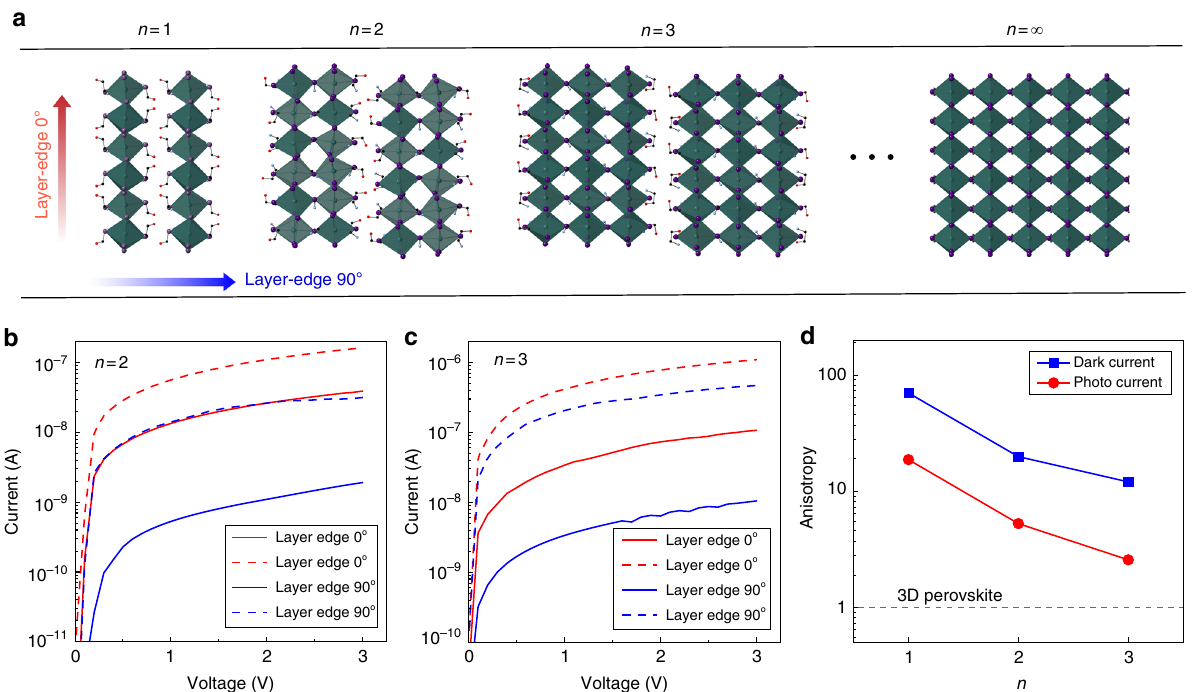
Fig. 3 Thickness-dependent electronic/opto-electronic properties. a Schematic image of 2D perovskites with n = 1, 2, 3, and ∞ . Dark and photo current of 2D perovskite with b n = 2 and c n = 3. d Anisotropy of conductance and photo conductance with different n